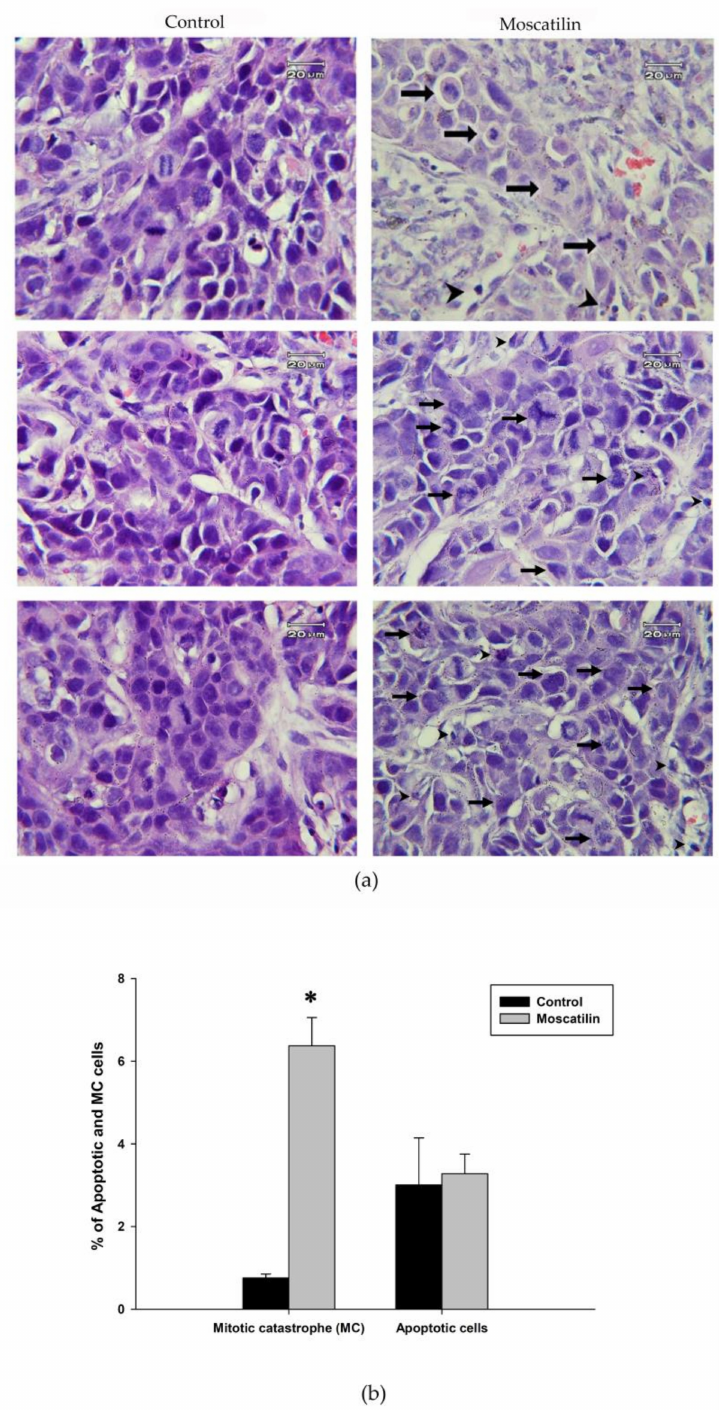
Figure 3. H&E-stained control and moscatilin-treatment for 60 days of ( a ) tumor samples. Aberrant mitotic cells with mitotic catastrophe (right panel arrows) and apoptotic cells (right panel arrowheads) were observed in tumor sections from moscatilin-treated mice but not in control mice. The quantification of mitotic catastrophe (MC) and apoptotic cells in control and moscatilin-treated tumor were shown in ( b ). Significant difference between control cells and cells treated with moscatilin are indicated by * p <